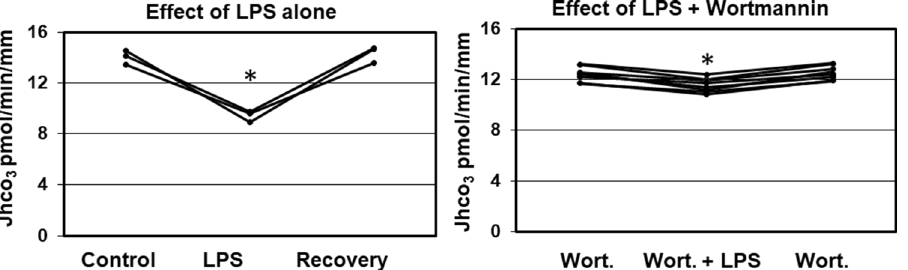
Figure 3. LPS added to the lumen at 500 ng/ml has less inhibitory effect on HCO 3 absorption by OMCDs from the inner stripe in the presence of 100–200 nM Wortmannin in the bath (R panel, n = 8 OMCDs) compared to LPS alone (L panel, n = 3